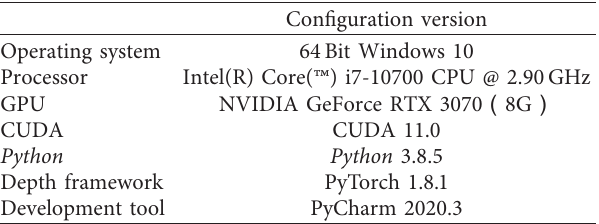
Figure 9: Diagrams of different data augmentation methods. (a) Original image. (b) Translation. (c) Random rotation. (d) Horizontal flip. (e) Vertical flip. (f) HSV saturation. Table 2: Configuration of